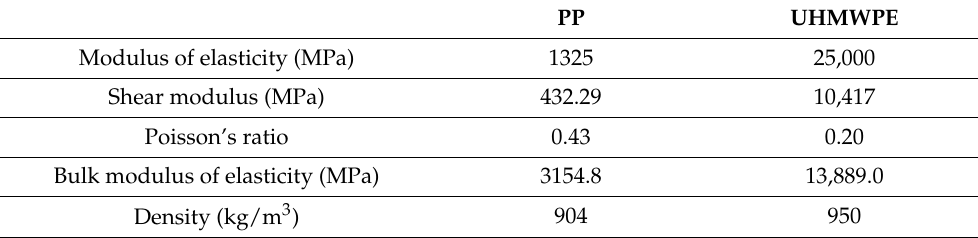
Table 1. Properties of PP and